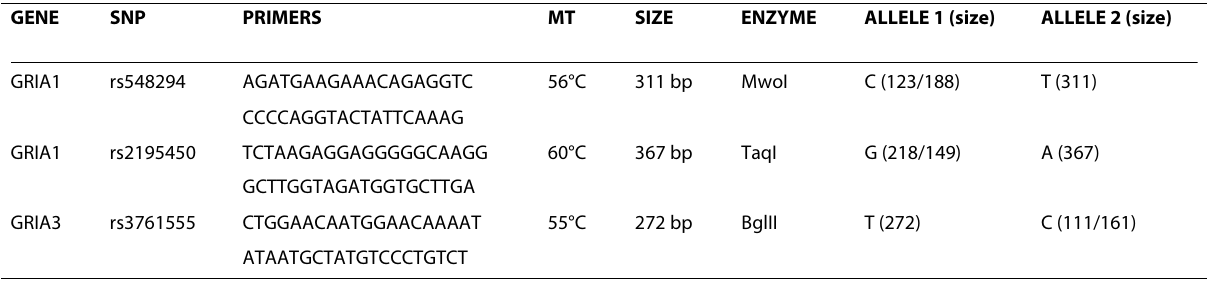
Table 1: primer sets, melting temperature (MT), PCRs size and genotyping conditions are reported for associated SNPs in GRIA1 and GRIA3